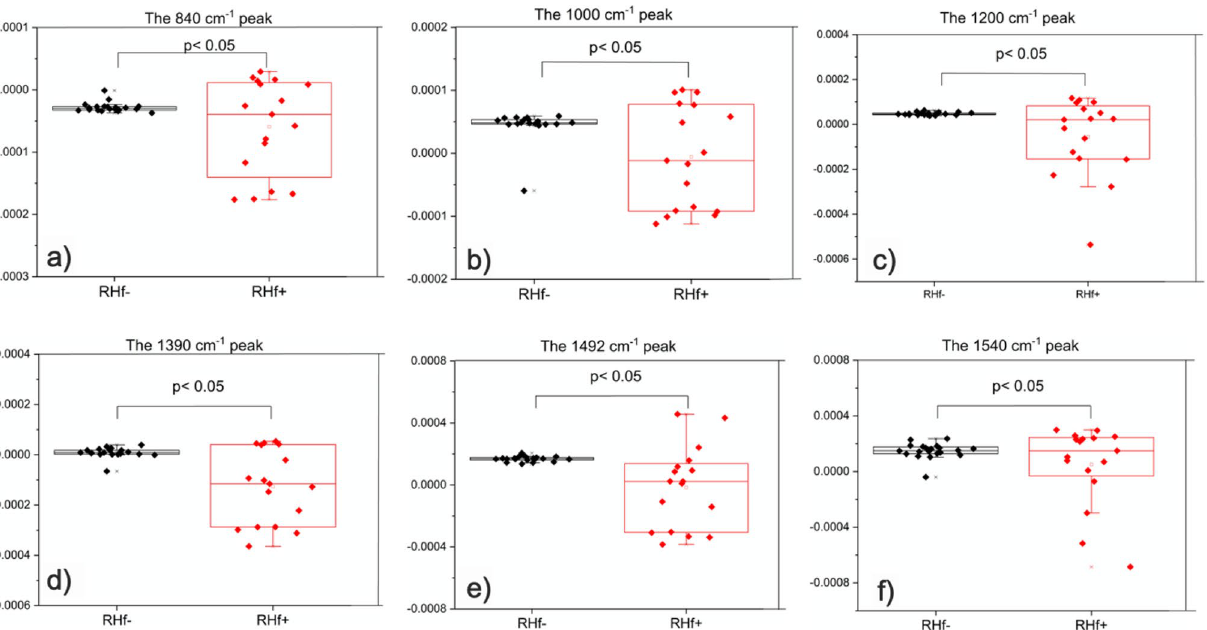
Figure 4. Intensity changes of peaks selected from PCA loading plot. All peaks are significantly different compared to the control group. Second derivative of spectra were used for calculating the mean ± SD represented by the boxes. Data was analyzed by one-way ANOVA and Fisher’s post hoc test.